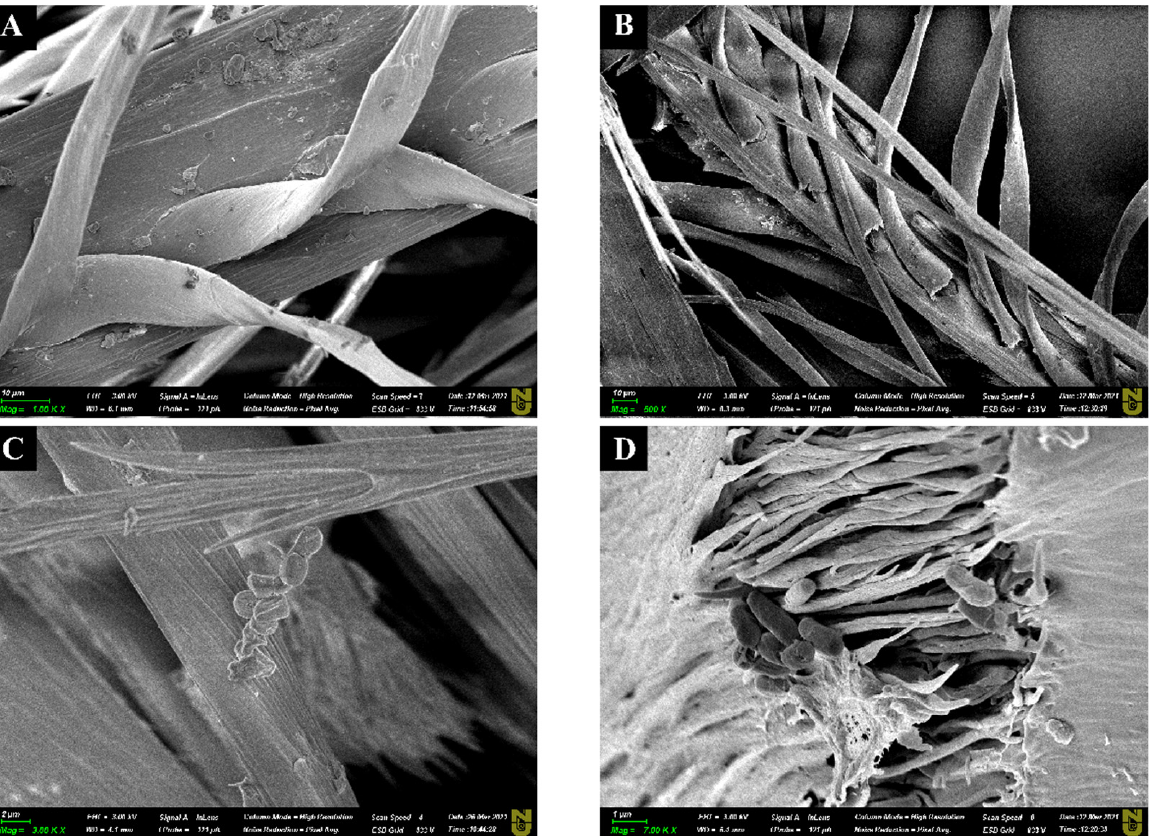
Figure 8. Scanning electron microscopy (SEM) images of chicken feather, where ( A ) is the intact feather, ( B ) and ( D ) show the feather after 48 h of incubation, and ( C ) is the feather after 144 h of incubation. Scale bars in ( A ), ( B ), and ( C ), 10 µm; and in ( D ), 1 µm.